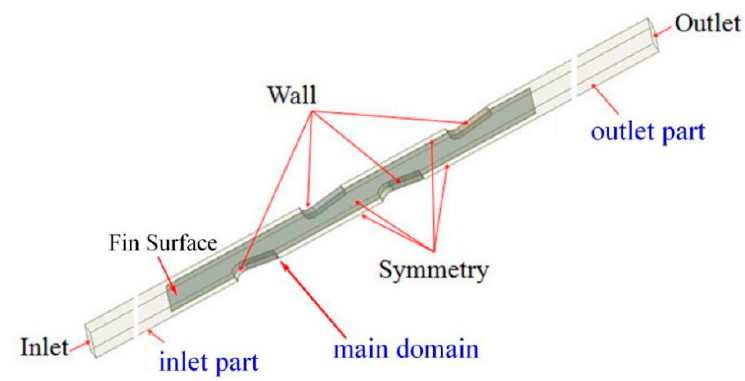
Figure 2. The schedule of boundary conditions on the plate fin-and-tube heat exchanger.